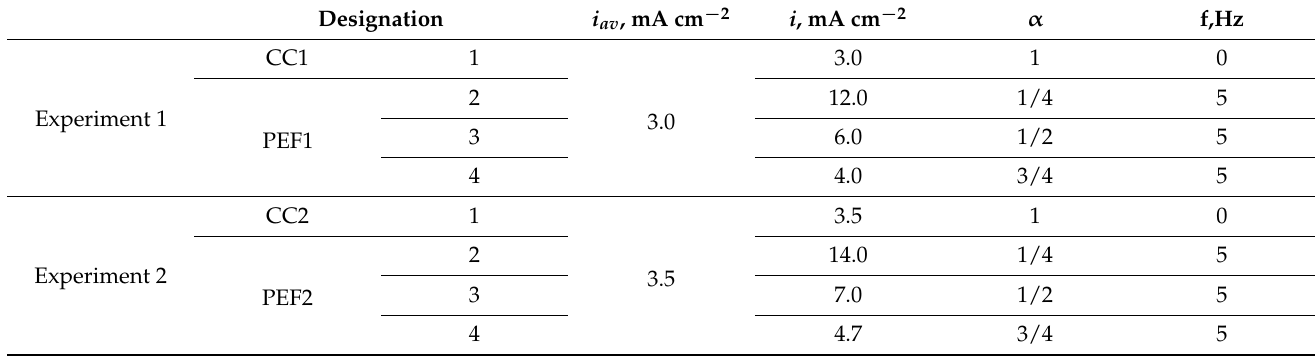
Table 3. Parameters of applied current modes during ED desalination of 0.03 M NaH 2 PO 4 solution. Designation